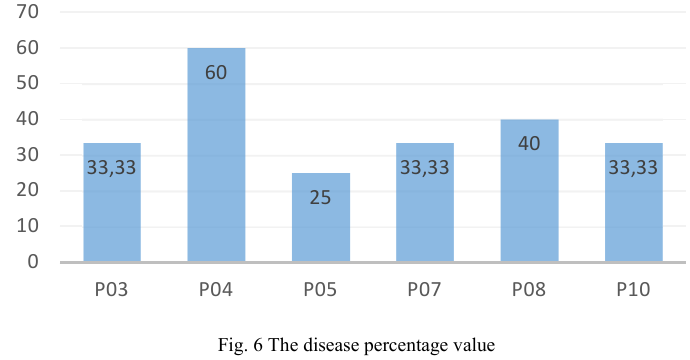
Fig. 6 The disease percentage